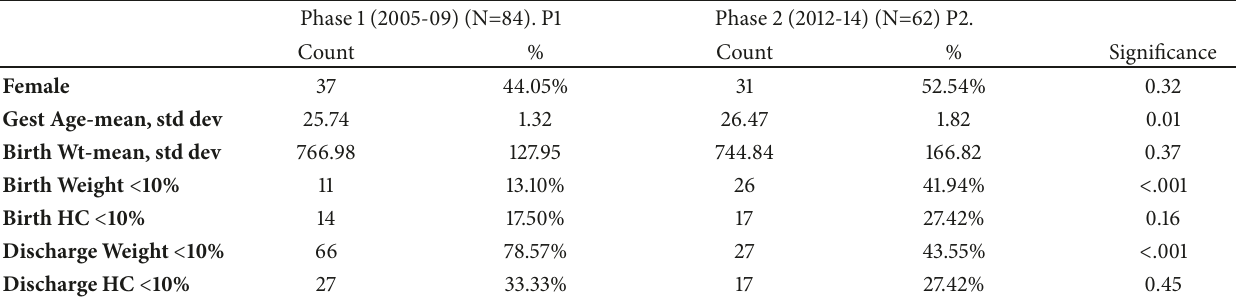
Table 1: Patient characteristics.